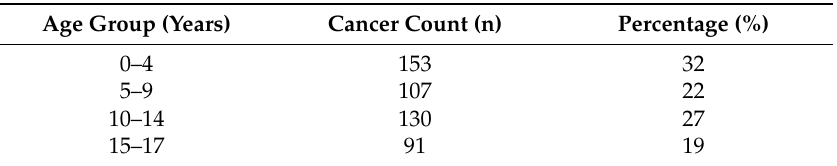
Table 5. Distribution of pediatric cancer by age at